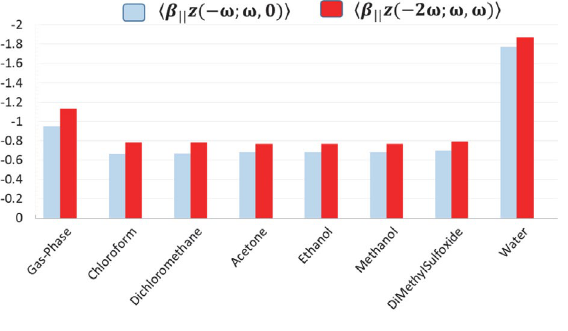
Figure 9: PCM-CAM-B3LYP/6-311++G(d,p) results for first hy- perpolarizabilities (10 –30 esu ) ‹ β || z (– ω; ω, 0,)› and ‹ β || z (–2 ω; ω, ω )› for ω = 0.04282 a. u. of compound C 5 H 8 O 2 in a solvent